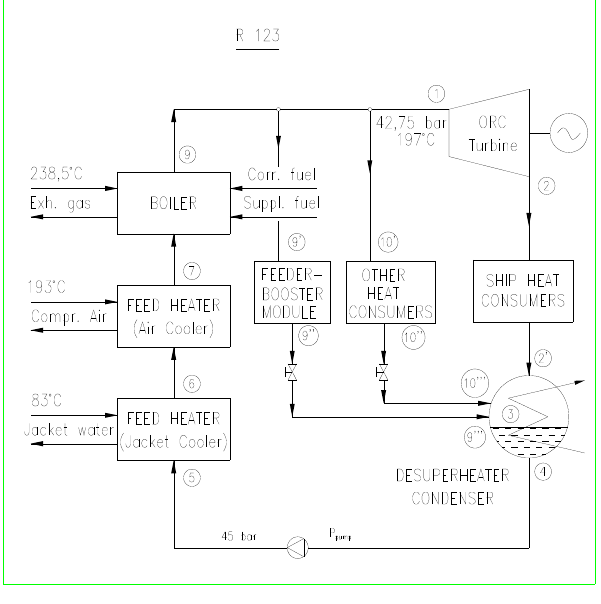
Figure 4. Schematic diagram of CHP plant with R123 fluid PP15